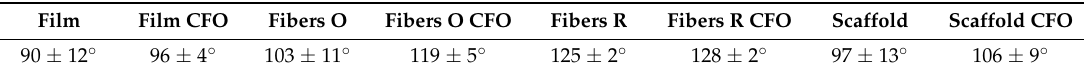
Table 2. Water contact angle measurement for the different samples (mean ± SD)